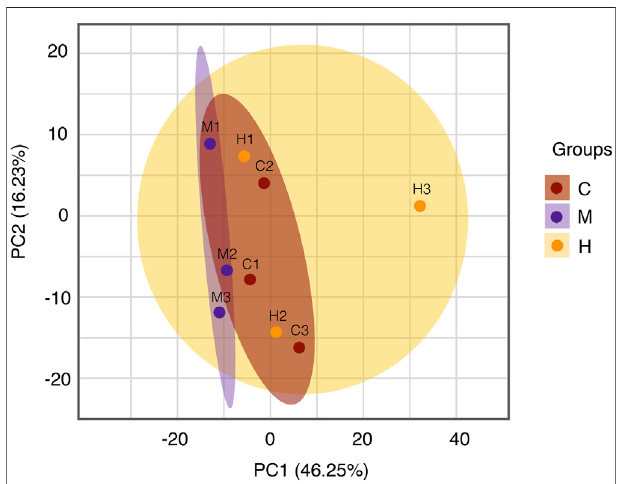
FIGURE 5 | PCA analysis. The central and vertical coordinates PC1 and PC2 indicate the scores of the fi rst and second principal components, respectively, and the color of the scattered dots indicates the experimental grouping of samples. C: normal control; M: model control; H: HQT control, n =